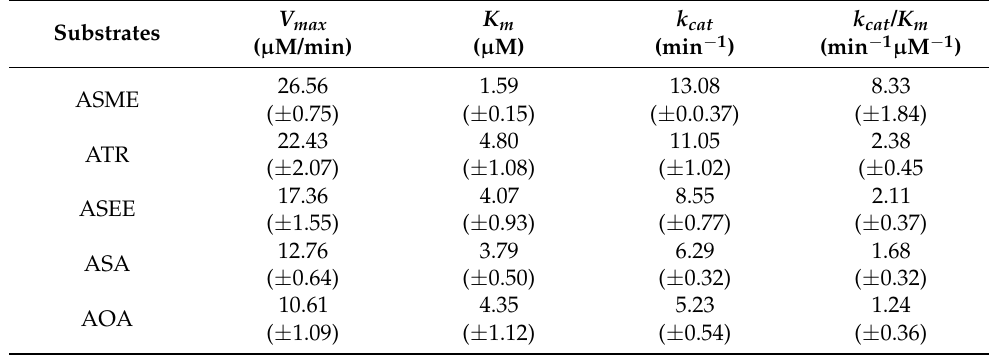
Table 1. Kinetic parameters of DBAT against several acetyl donors for the synthesis of